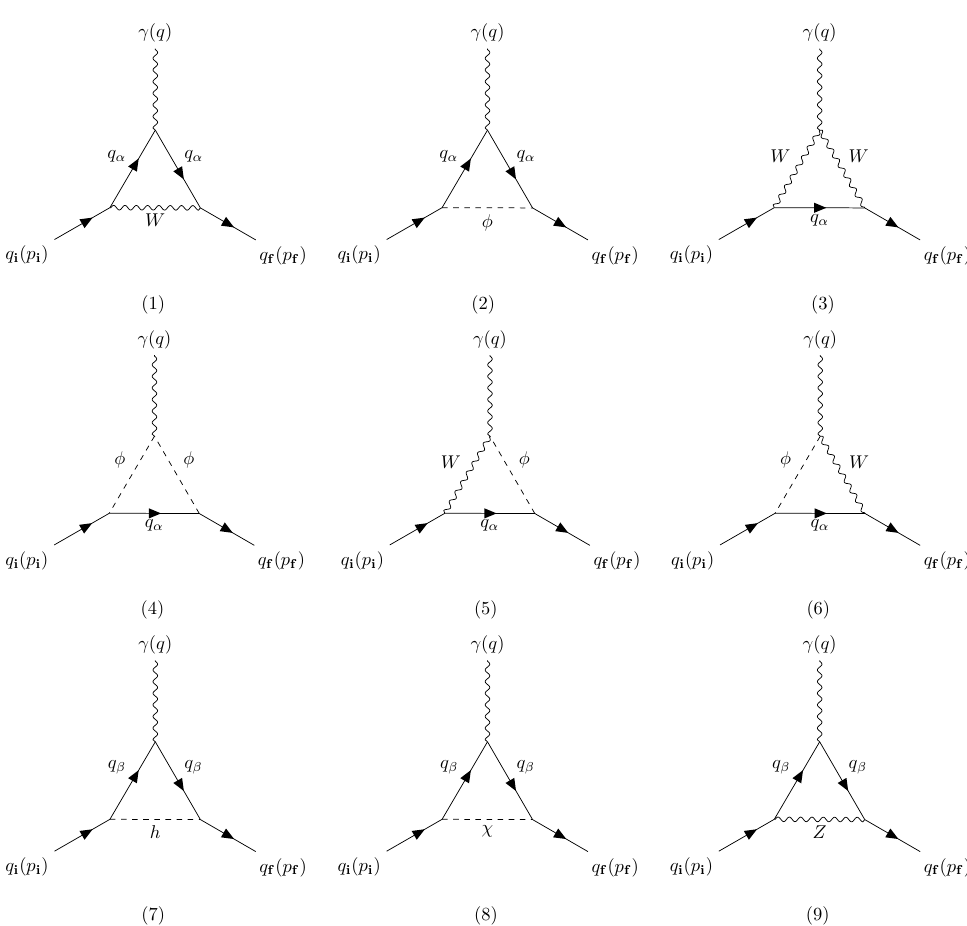
Figure 1 . Feynman Diagrams for the one-loop vector-like quark decay induced by electroweak interactions. We denote the amplitudes for the nine diagrams as M 1 − M 9 accordingly. We note that amplitudes M 7 − M 9 contain flavour changing neutral vertices. We denote q = p f − p i and p is the loop momentum running through the bottom edge of each diagram that is integrated